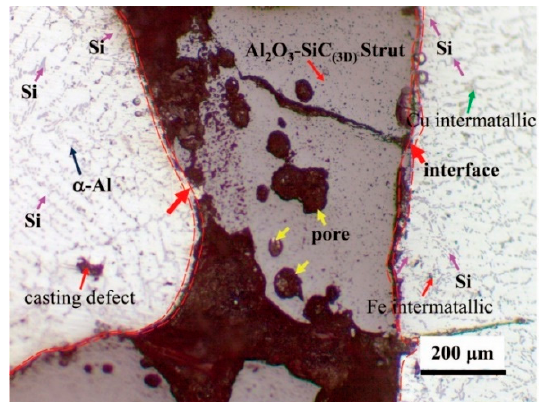
Figure 18. Microstructure of Al 2 O 3 -SiC (3D) /Al alloy composite.